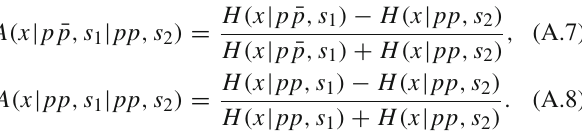
√ √ s 1 , s 2 ≥ 1 TeV. Indeed, as shown in Fig. 18, this 0 for asymmetry parameter is significantly different from zero.